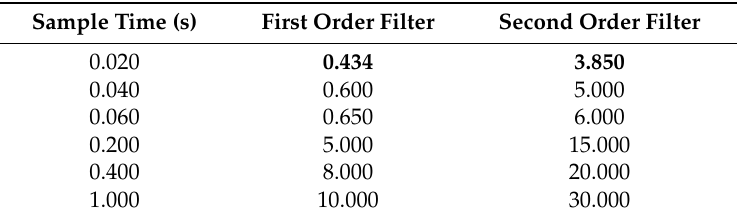
Table 5 recommends the parameters of the channel filters to detect or isolate a typical fault in different sampling time (the Monte Carlo simulation performed 1000 times; the step fault is 5 ◦ /h; the false alarm rate and false isolation rate are 0.05 respectively). Table 5. Parameters recommended for fault detection and isolation (FDI) with the typical fault in different sampling